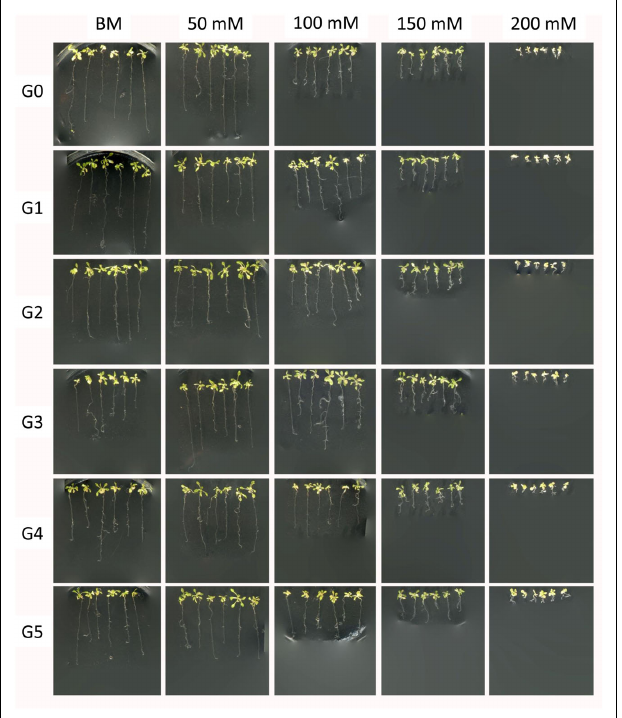
FIGUREA1 | Representative images of G0–G5 generations of plants exposed to 50mM of Cd 2 + grown in the presence of various concentrations of Cd 2 + . Plants were germinated and grown in the presence of various amount of Cd 2 + .Two weeks after germination plants were pulled from the medium and used for measurements of the root length. Several representative plants were placed on the agar for imaging purposes. “G0” – non-exposed plants; “G1–G5” – first through fifth generation of plants exposed to 50mM Cd 2 + ; “BM” – basic medium; “50–200mM” – concentration of Cd 2 + in the basic